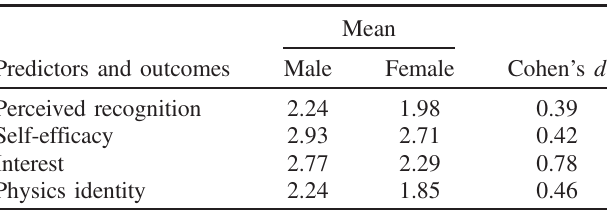
TABLE IV. Mean postpredictor and outcome values in physics 2 by gender as well as statistical significance ( p values) and effect sizes (Cohen ’ s d ) by gender. 563 matched students are included with 361 women and 202 men. All p values < 0 . 001